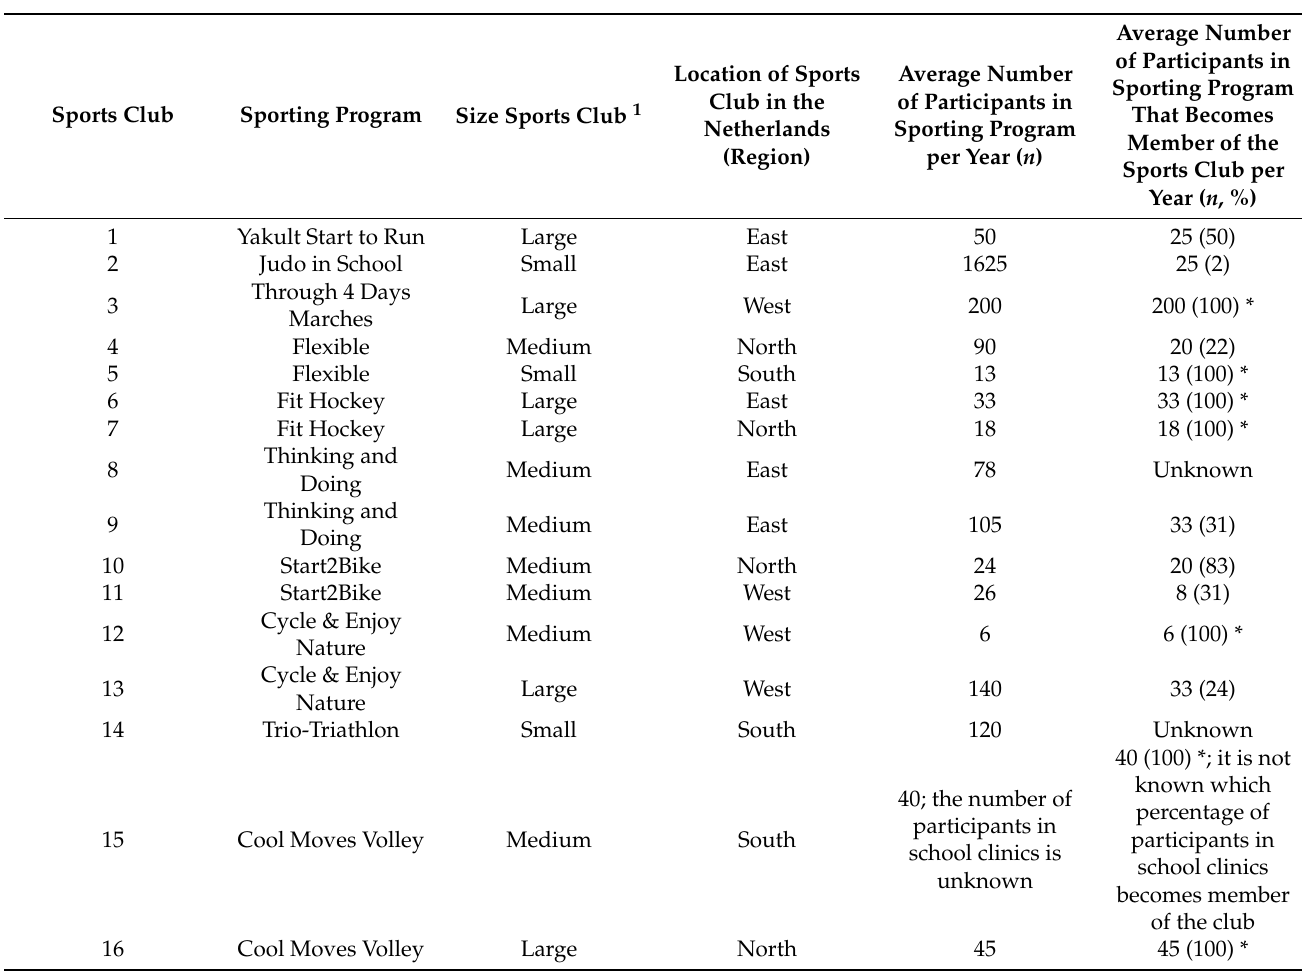
Table 3. Descriptive characteristics of included sports